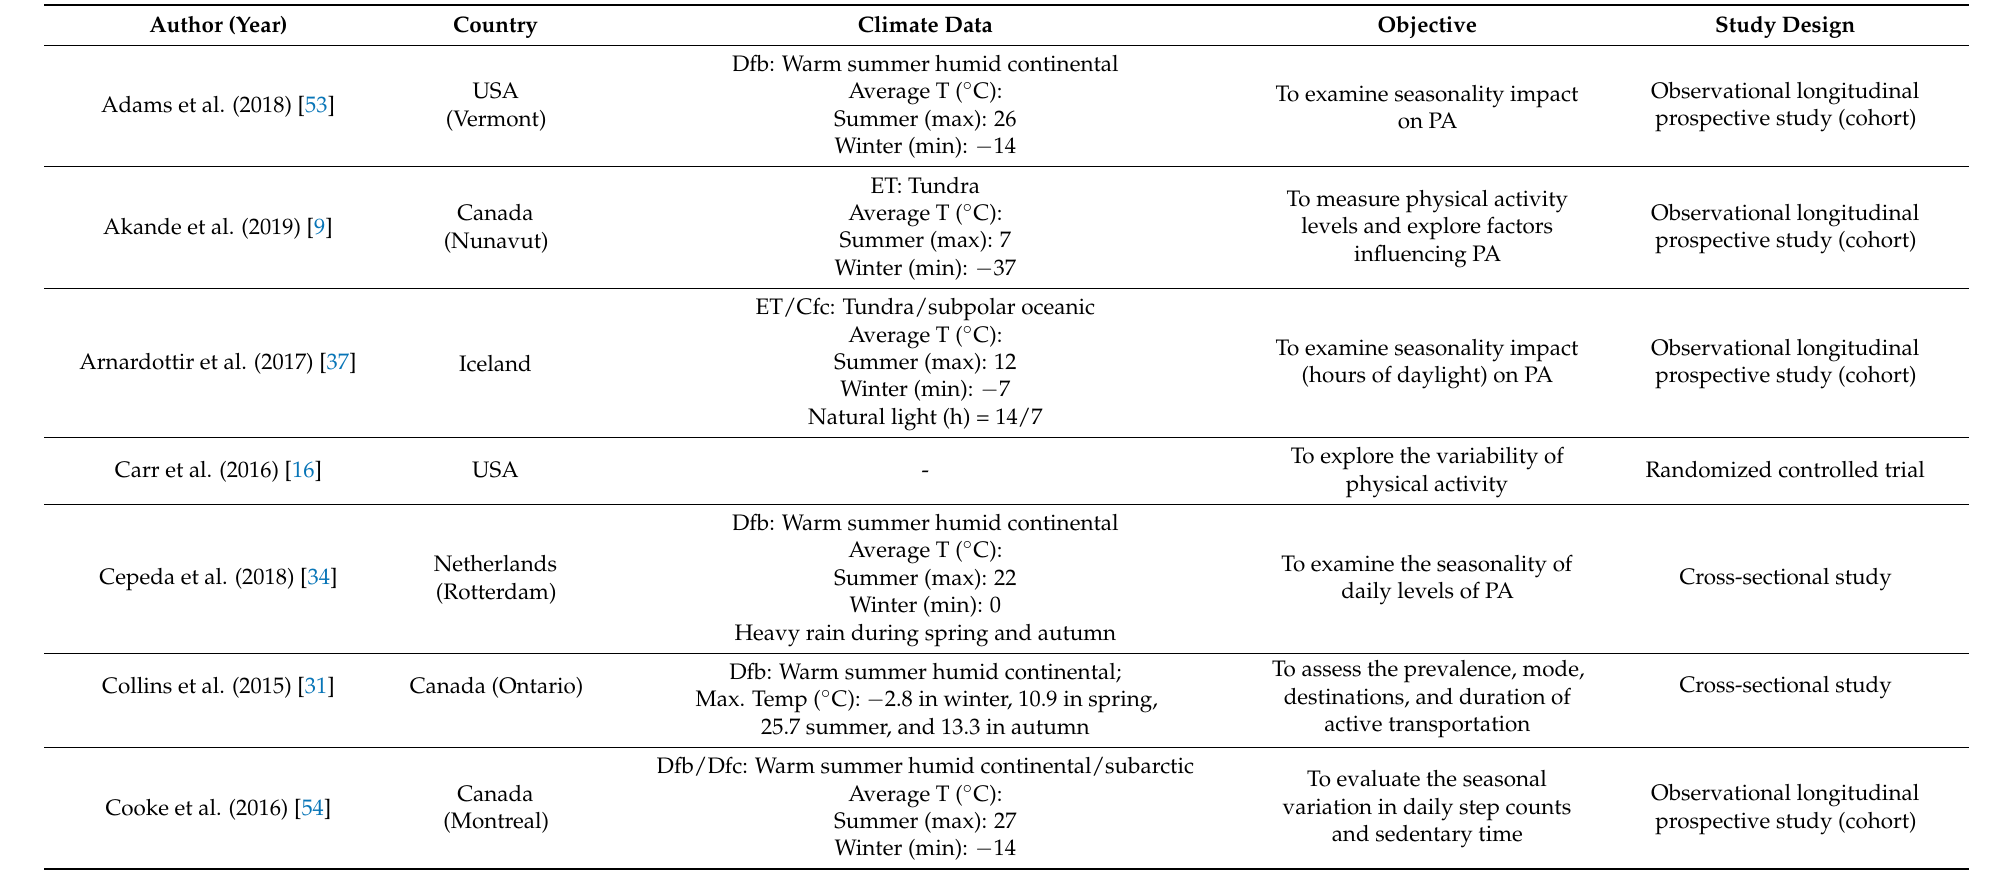
Table 1. Descriptive characteristics and results of the included